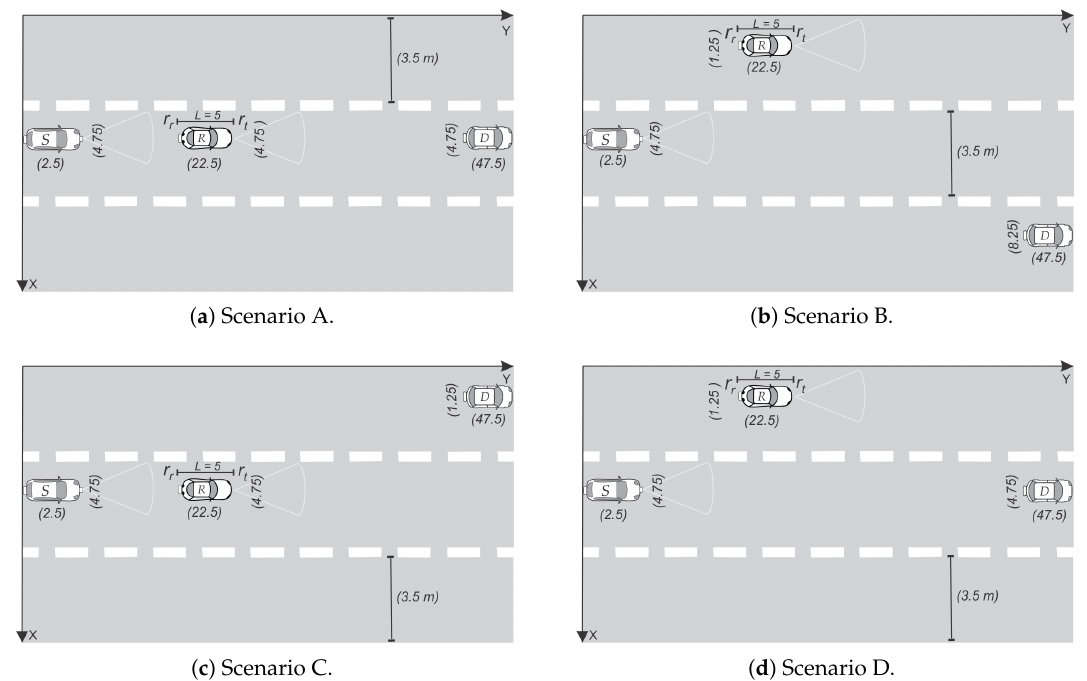
Figure 5. Pictorial representation of the four different scenarios of simulation for the straight roadway case.